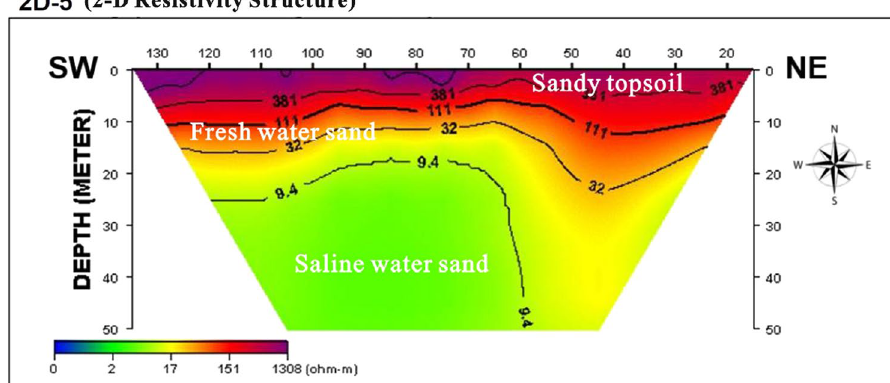
Fig. 8 Resistivity imaging of Traverse 2D-4 Fig. 9 Resistivity imaging of Traverse 2D-5